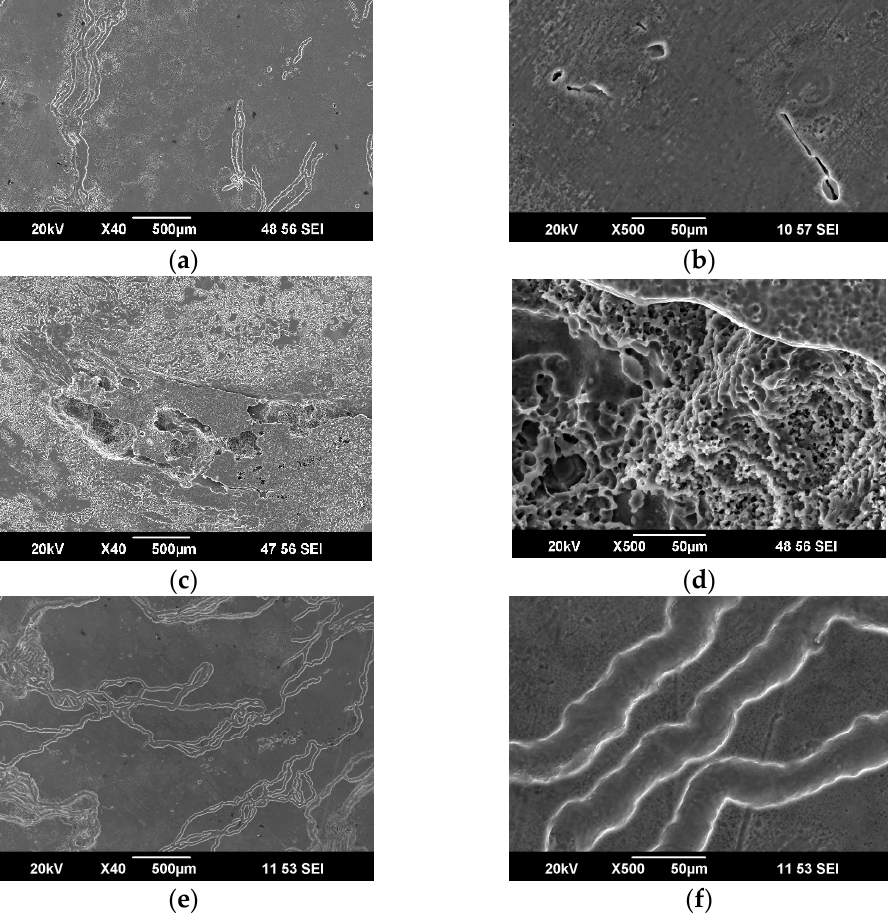
Figure 3. Surface structure of the Mg-1Zn-0.2Ca alloy samples: ( a , b ) in the homogenized state, ( c , d ) after HPT, ( e , f ) after HPT and additional HT at 300 °C, after 1 day of exposure in Ringer’s solution.